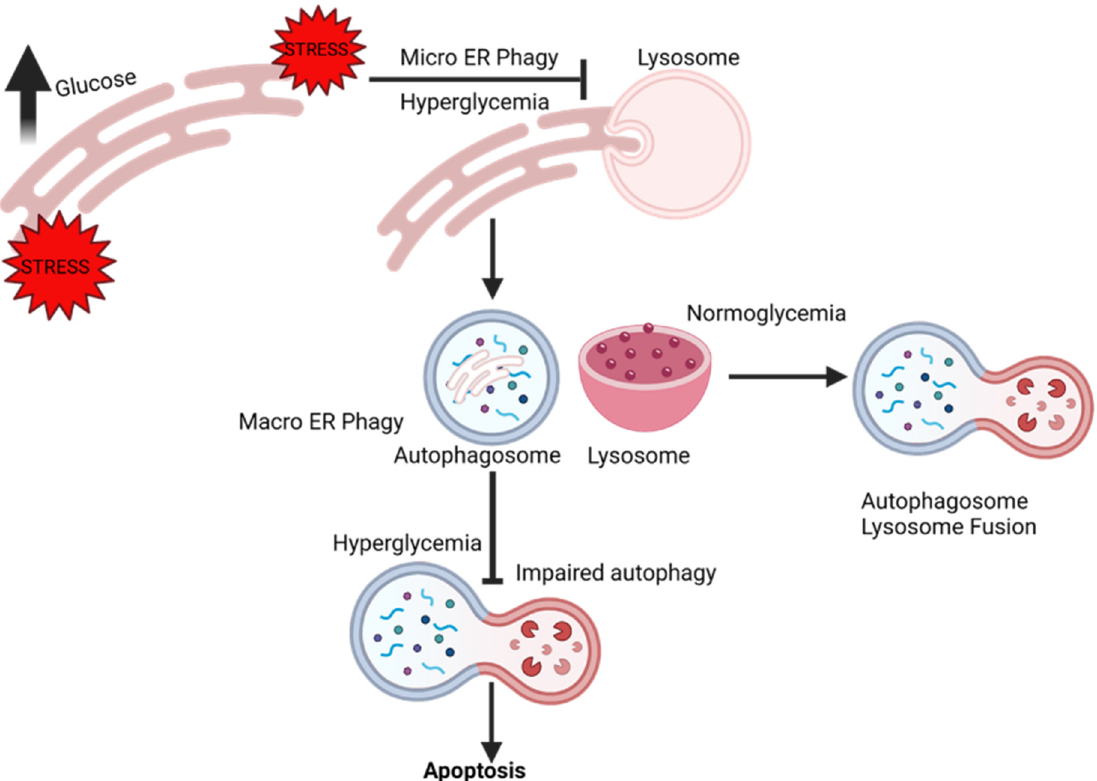
Figure 4. Chronic hyperglycemia disrupts endoplasmic reticulum (ER) homeostasis. When disruption of homeostasis occurs within the ER, the ER initiates the adaptive ER-stress responses such as the unfolded protein response (UPR) and autophagy. Lysosomes engulf portions of damaged ER during micro ERphagy, whereas the autophagy machinery is involved in macro ERphagy. Activation of the adaptive stress responses alleviates stress and restores homeostasis. However, unresolvable UPR activation due to chronic hyperglycemia exhausts the ER stress response, impairs autophagy, and promotes apoptosis.